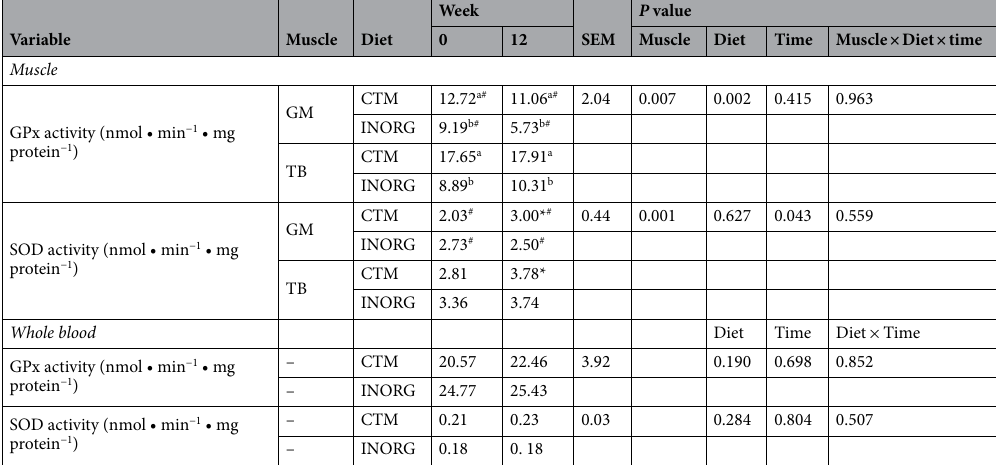
Table 2. Pre-trailer muscle glutathione peroxidase (GPx) and superoxide dismutase (SOD) activities in the gluteus medius (GM) and triceps brachii (TB), and whole blood GPx and SOD activities at 0 and 12 weeks of submaximal exercise training in yearling horses supplemented with either complexed trace minerals (CTM; n = 8) or inorganic trace minerals (INORG; n = 8). *Within a row, mean differs from week 0 ( P ≤ 0.05). a,b Within a column, differing letters indicate CTM differs from INORG within the specified variable ( P ≤ 0.05). # Within a column, GM differs from TB ( P ≤ 0.05).